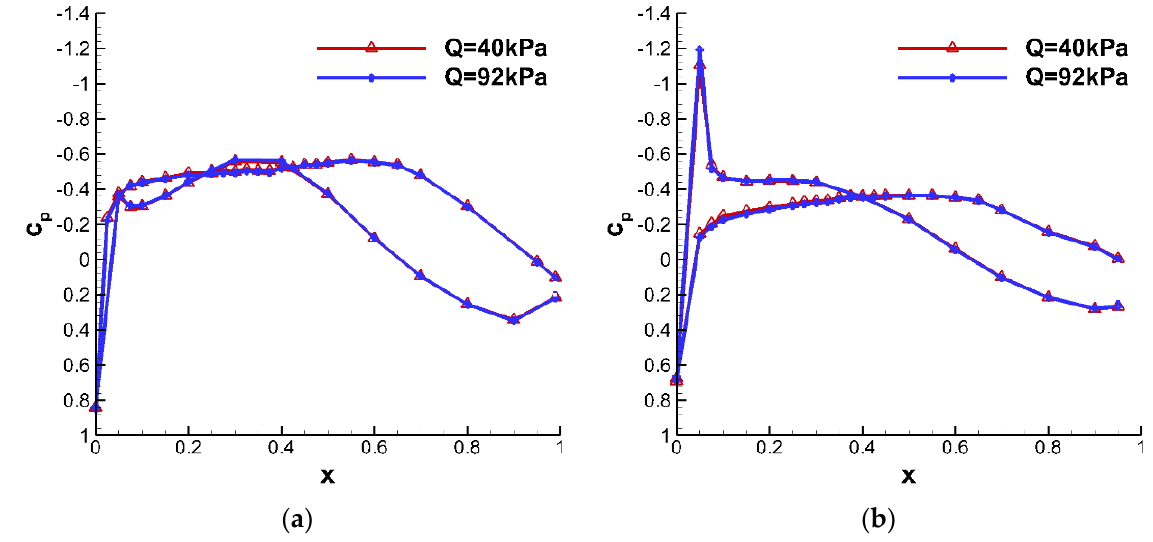
Figure 6. Pressure distributions under different dynamic pressures (α = 0°, M = 0.76, Re = 15 × 10 6 ): ( a ) η = 54%; ( b ) η = 96.61%.